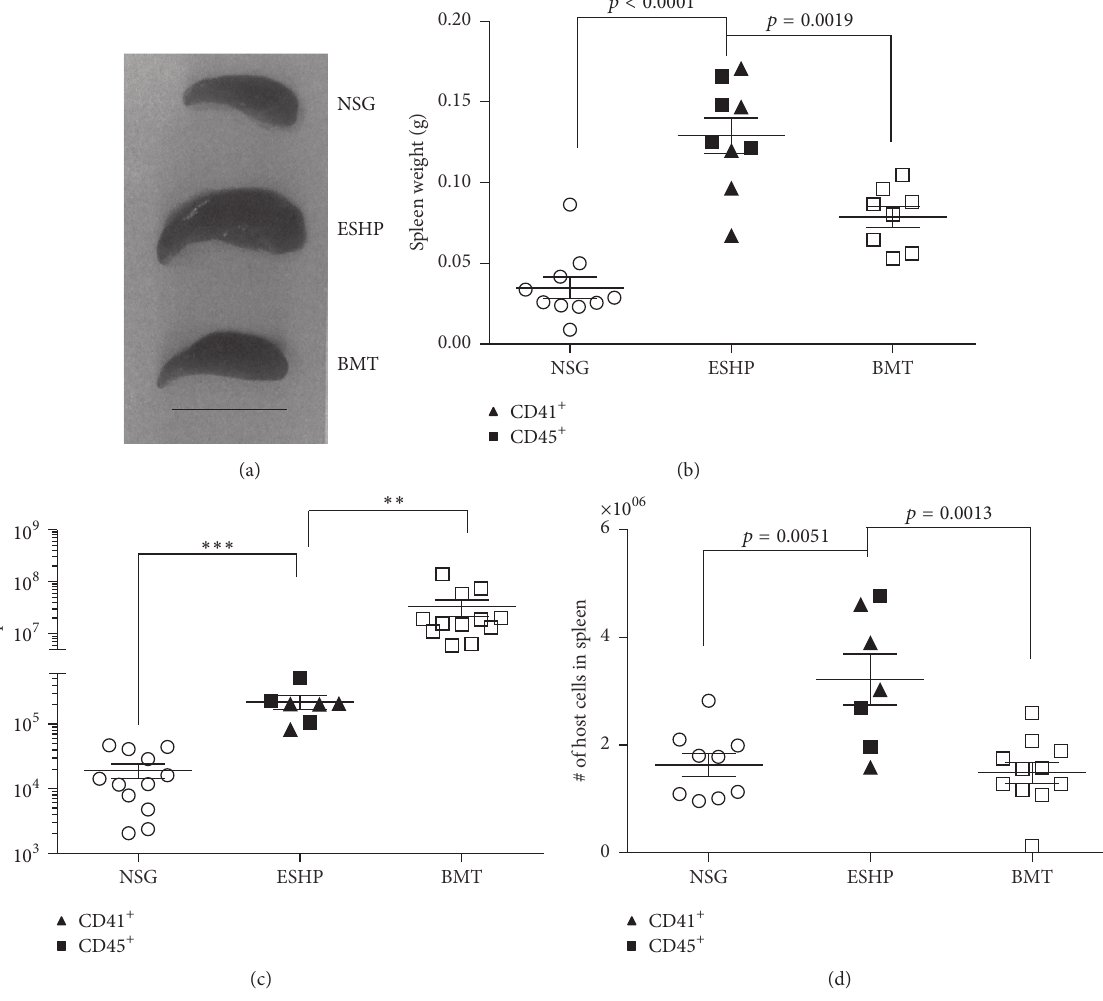
Figure 2: Enlarged spleens in ESHP recipients. (a) Photos of spleens at day 18 after transplant; scale bar = 1 cm. (b) Spleen weights at days 17–34 after transplant for ESHP recipients (CD41 filled triangles ( 𝑛 = 5 ), CD45 filled squares ( 𝑛 = 4 )), untransplanted NSG ( 𝑛 = 10 ), and whole BMT recipients ( 𝑛 = 8 ). (c) Absolute numbers of donor-derived cells (CD41 ( 𝑛 = 4 ), CD45 ( 𝑛 = 3 )) and untransplanted NSG ( 𝑛 = 11 ). (d) Absolute numbers of host-derived cells in ESHP recipients (CD41 ( 𝑛 = 4 ), CD45 ( 𝑛 = 3 )) compared to untransplanted NSG ( 𝑛 = 11 ) controls. Bars represent mean ± SEM; ∗∗ 𝑝 < 0.01 ; ∗∗∗ 𝑝 < 0.001